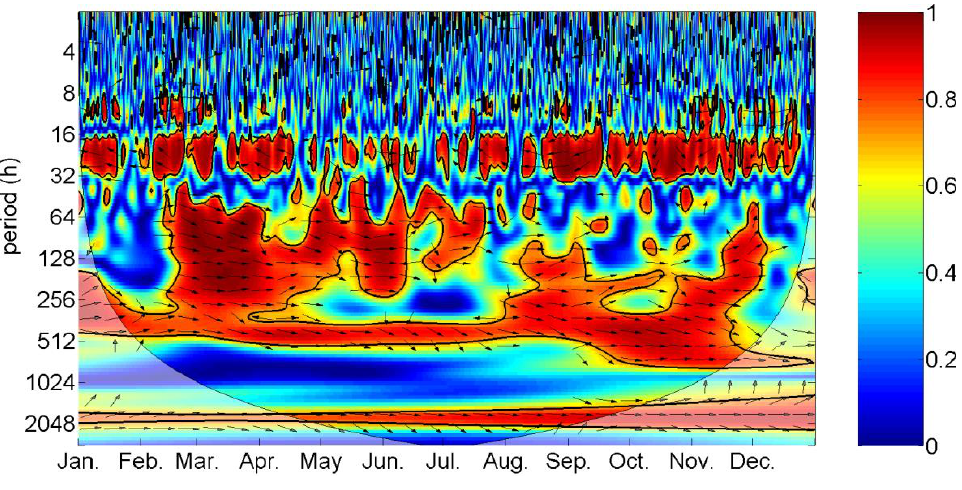
Figure 9. Variants of WQI of Suceava River upstream (blue line) and downstream (orange line) in 2019 (temporal evolution based on hourly data): ( a ) rectified WQI; ( b ) partial